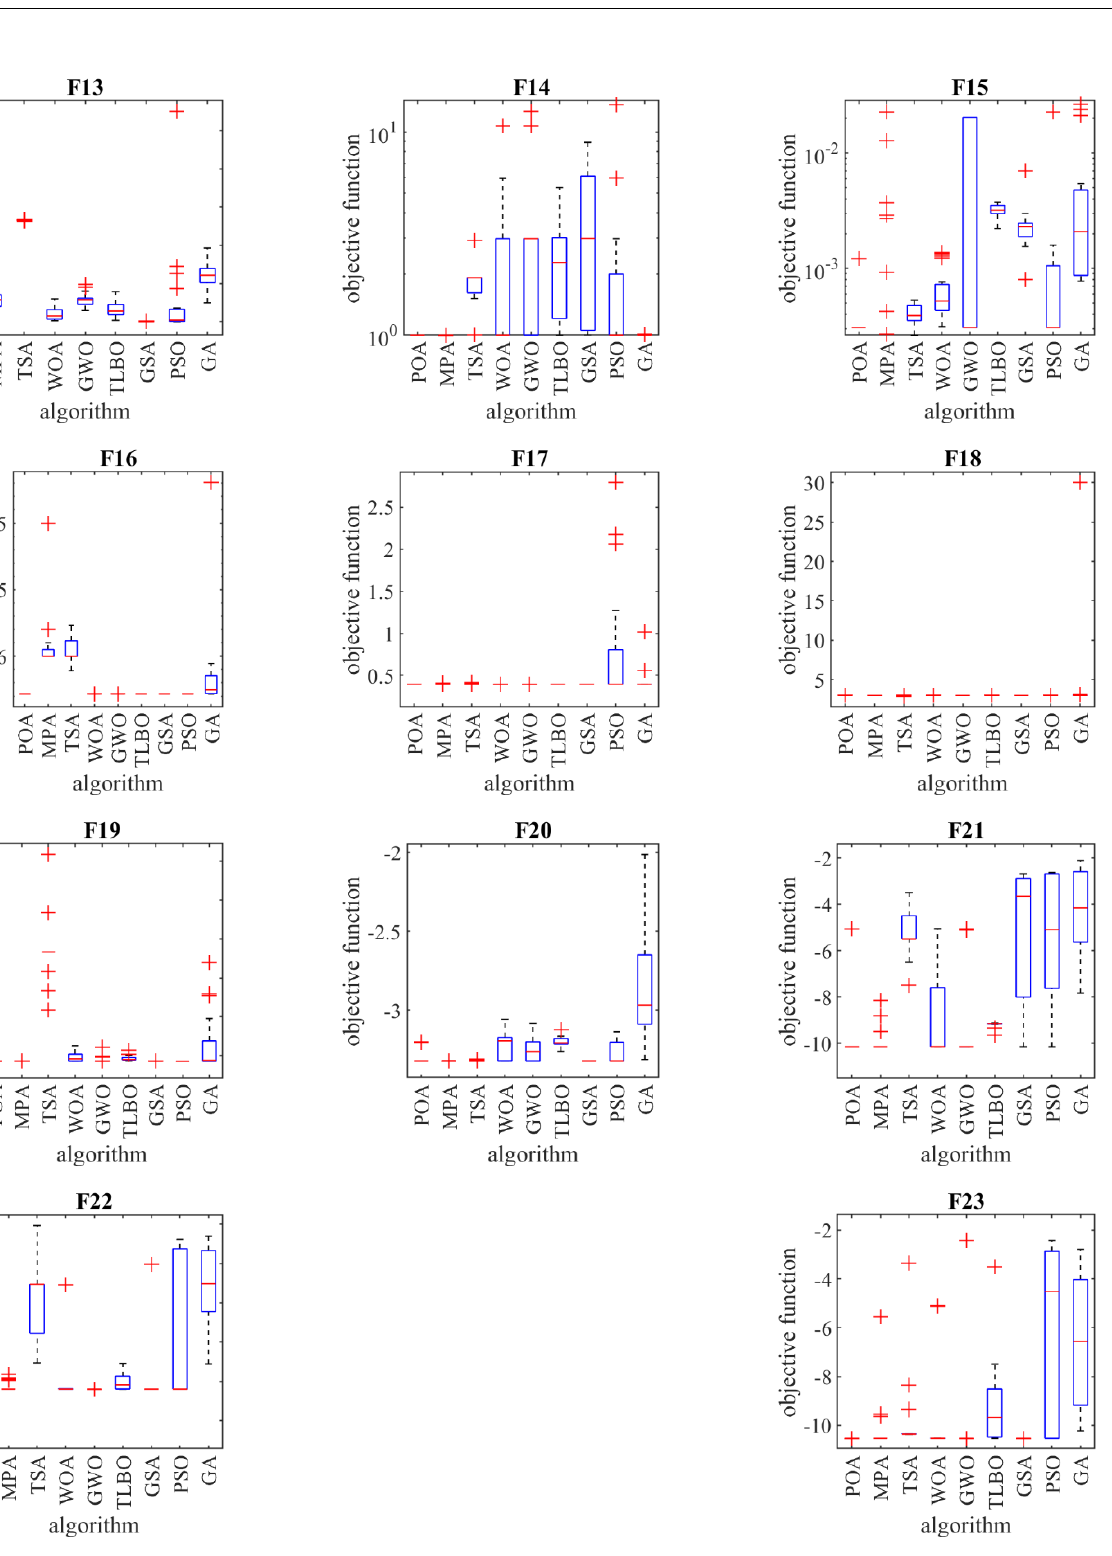
Figure 2. Boxplot of composition objective function results for different optimization algorithms.